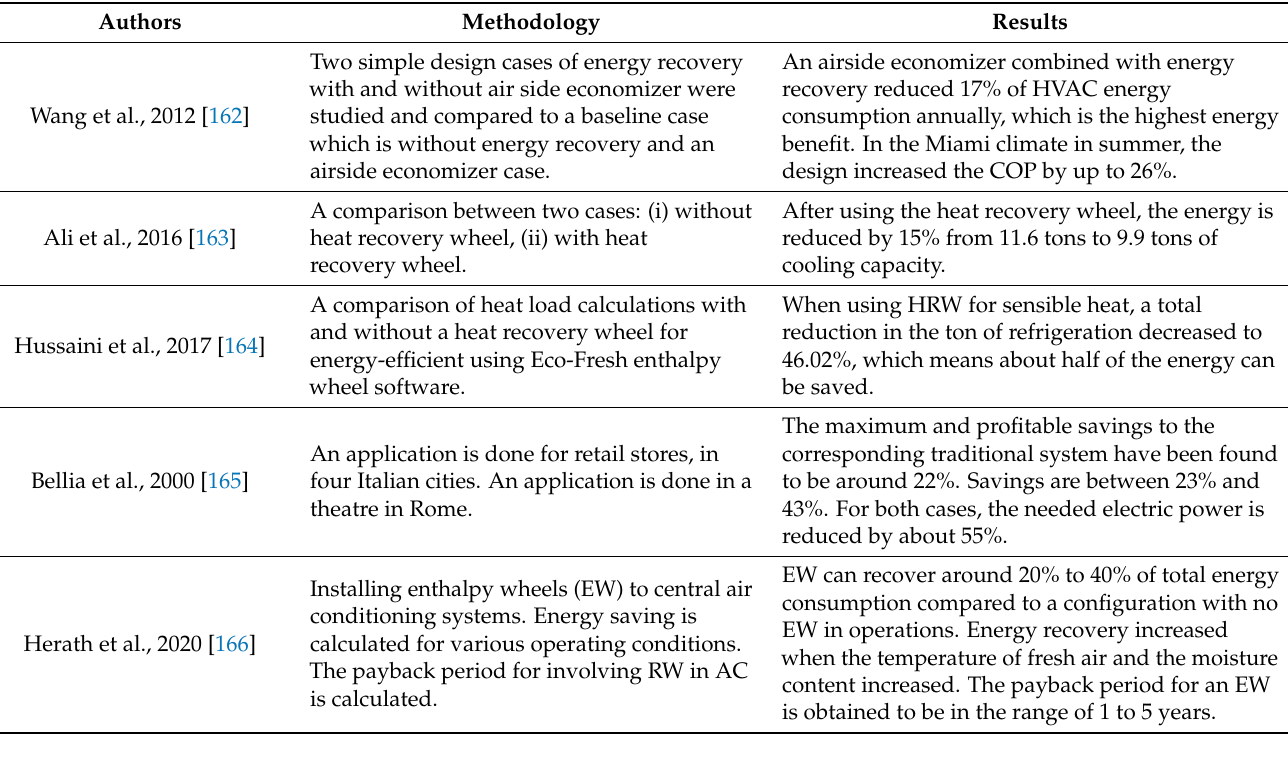
Table 7. Summary of the investigated papers related to the enthalpy wheel effect on HVAC